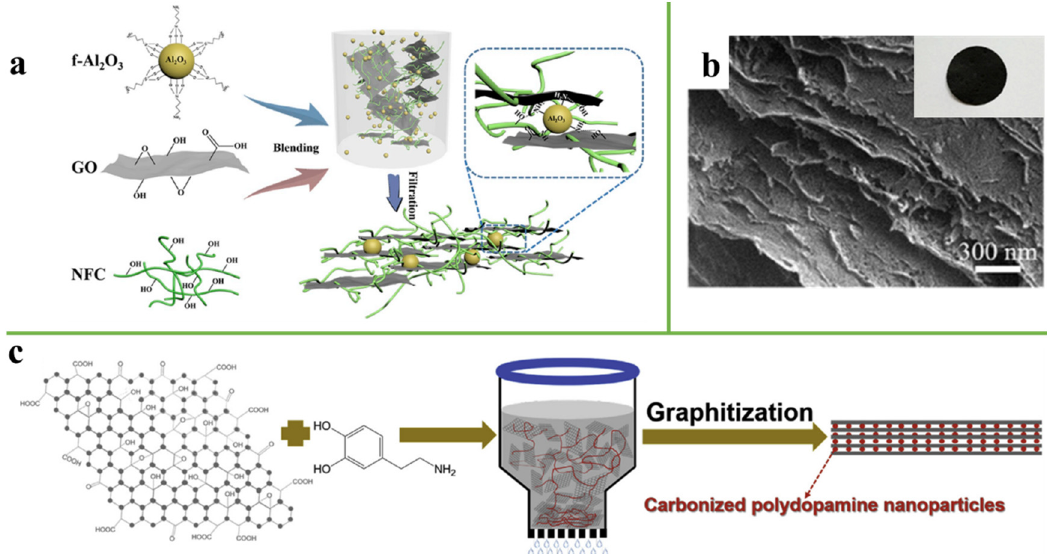
Figure 1. ( a ) Schematic illustration of the fabrication process of a f-Al 2 O 3 @RGO/NFC composite film by vacuum filtration. Reprinted with permission from ref. [22] Copyright 2019, Elsevier. ( b ) Macroscopic photograph and cross-sectional SEM views of composite film. ( c ) Schematic illustration of GF. Reprinted with permission from ref. [24] Copyright 2019,